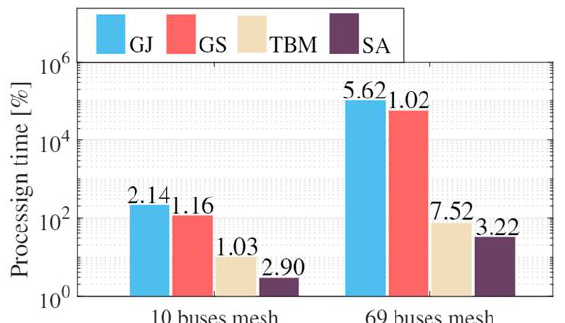
Figure 6. Processing time of the solution methods: Newton–Raphson (NR), Gauss–Jacobi (GJ), Gauss–Seidel (GS), Taylor-Series-Based Approximation (TBM), and Successive Approximation (SA) with respect to the base case